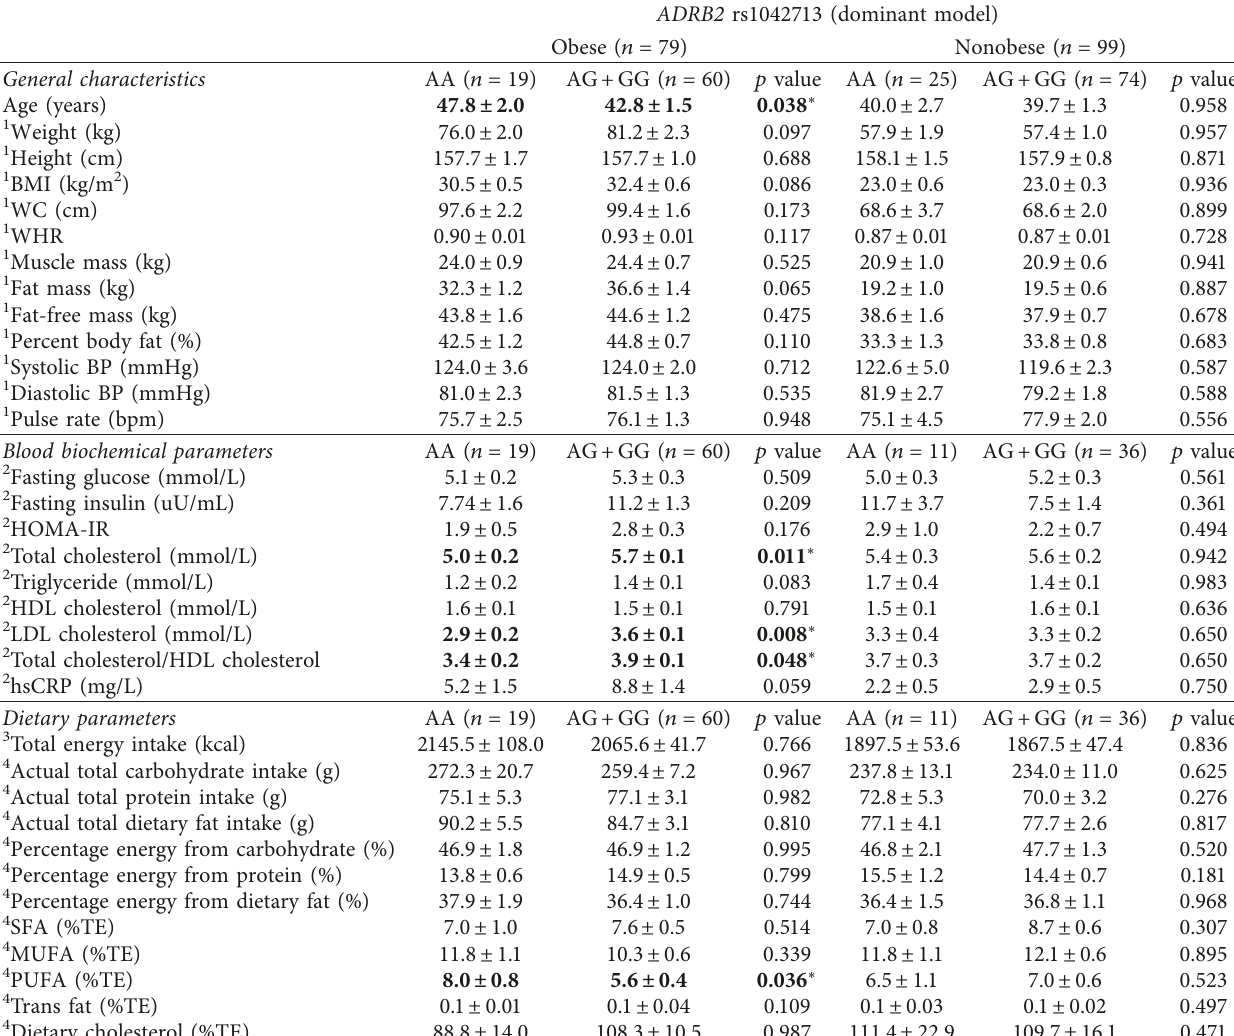
Table 4: Differences in means ( ± SE) between ADRB2 rs1042713 gene variants in anthropometric, biochemical, and dietary parameters in obese and nonobese groups.